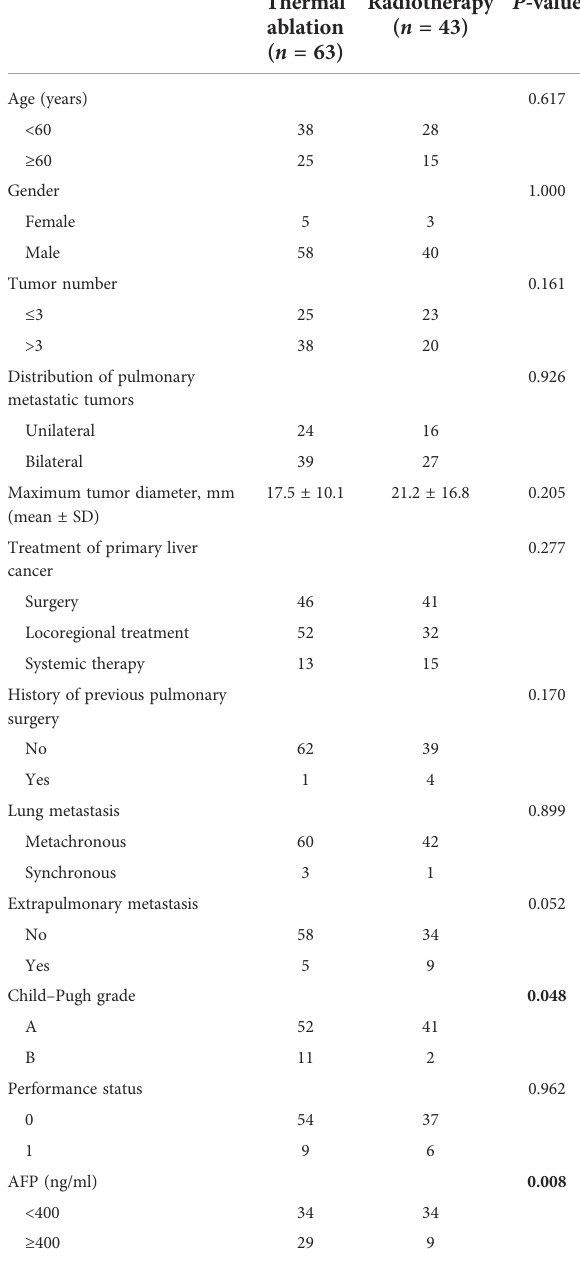
TABLE 1 Baseline characteristics of patients with pulmonary metastases from hepatocellular